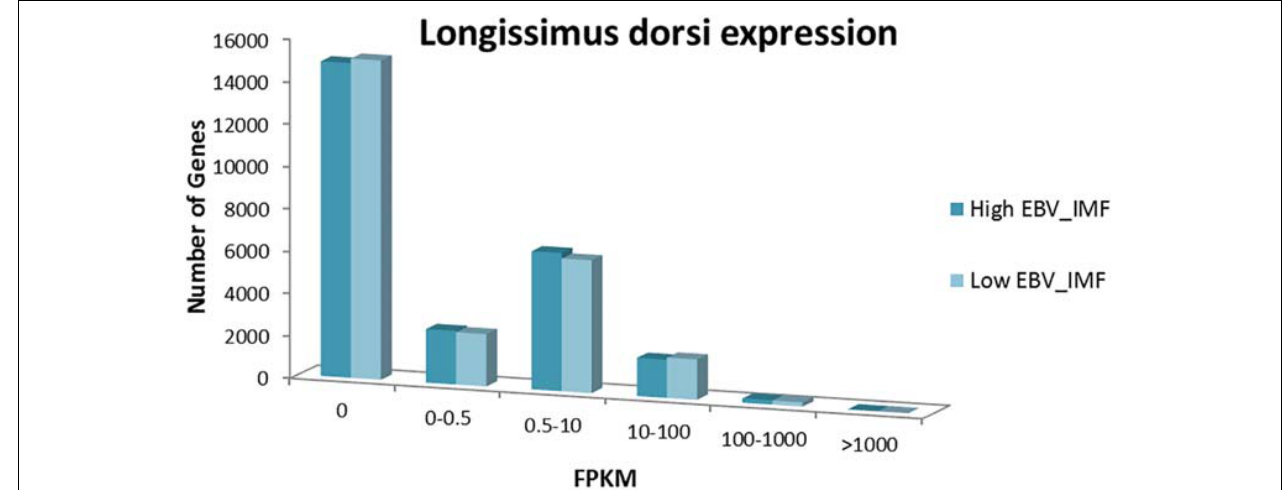
FIGURE 1 | Gene expression distribution of the 25,878 genes annotated in the pig genome (Sscrofa11.1) in fragments per kilobase million (FPKMs) normalized values in the H and L groups.